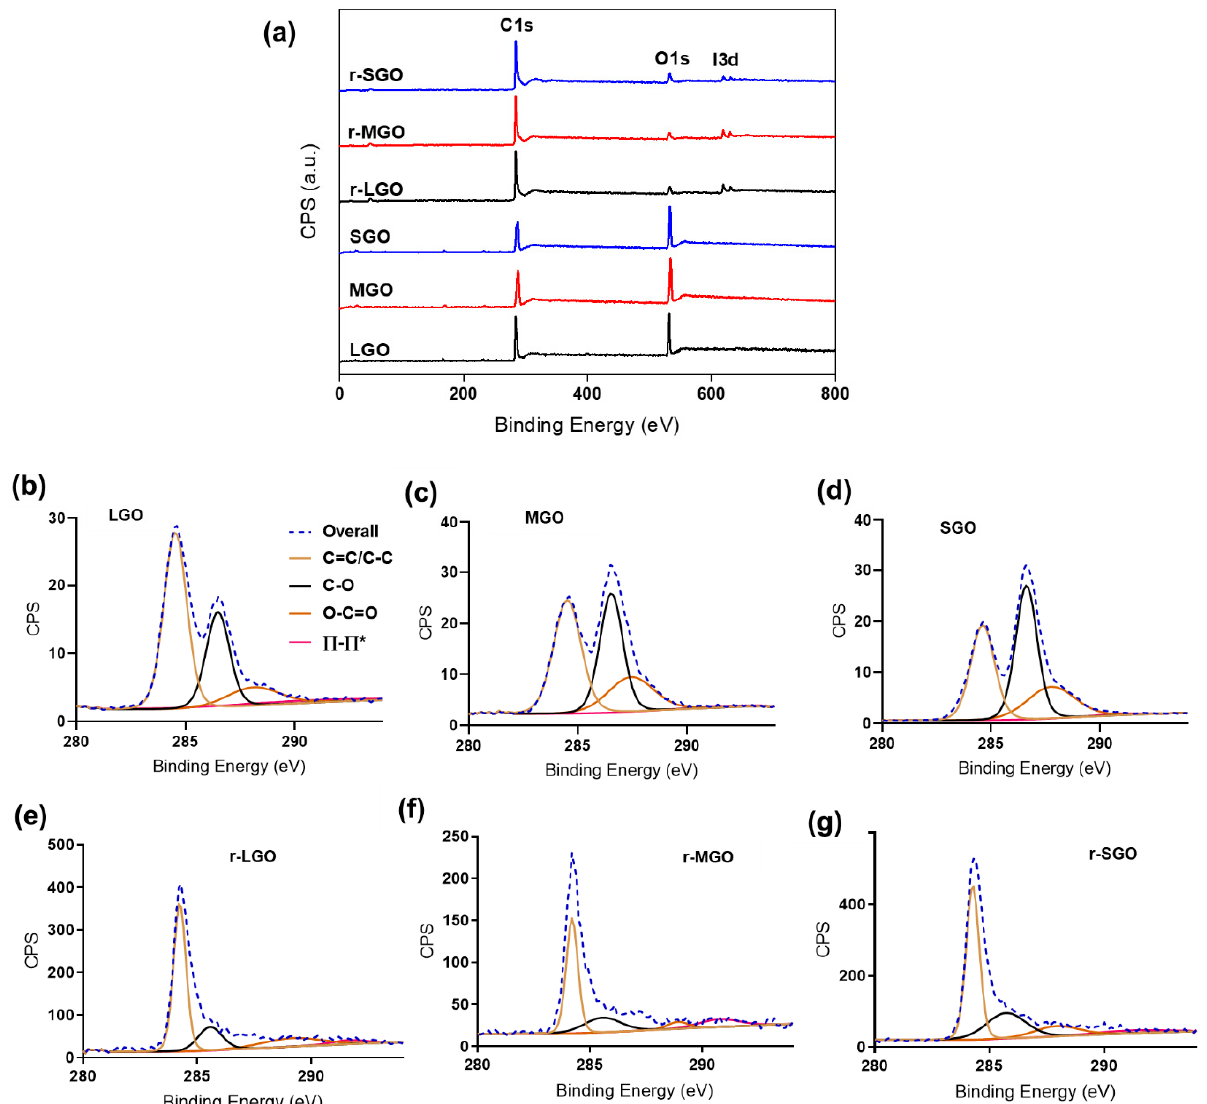
Figure 1. XPS characterization of rGO prepared using different-sized GO in suspension. ( a ) General survey XPS spectra of three GO samples and corresponding rGO prepared using HI acid as reductant. ( b – g ) XPS C1s deconvolution spectra of ( b ) LGO, ( c ) MGO, ( d ) SGO, ( e ) r-LGO, ( f ) r-MGO, ( g ) r-SGO. Table 2. Summary of XPS and Raman spectra analysis of rGO samples prepared with different size GO in suspension and film. Error bars represent standard error of mean (SEM), n = 3.